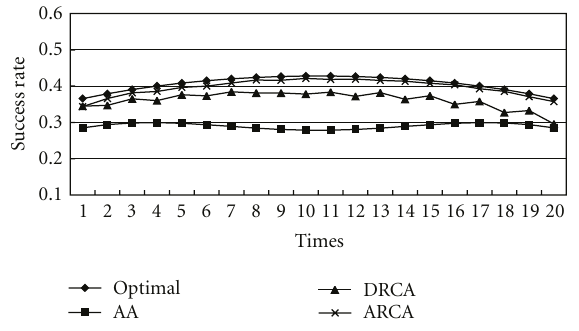
Figure 3: Total transmission success rate in Case 2.